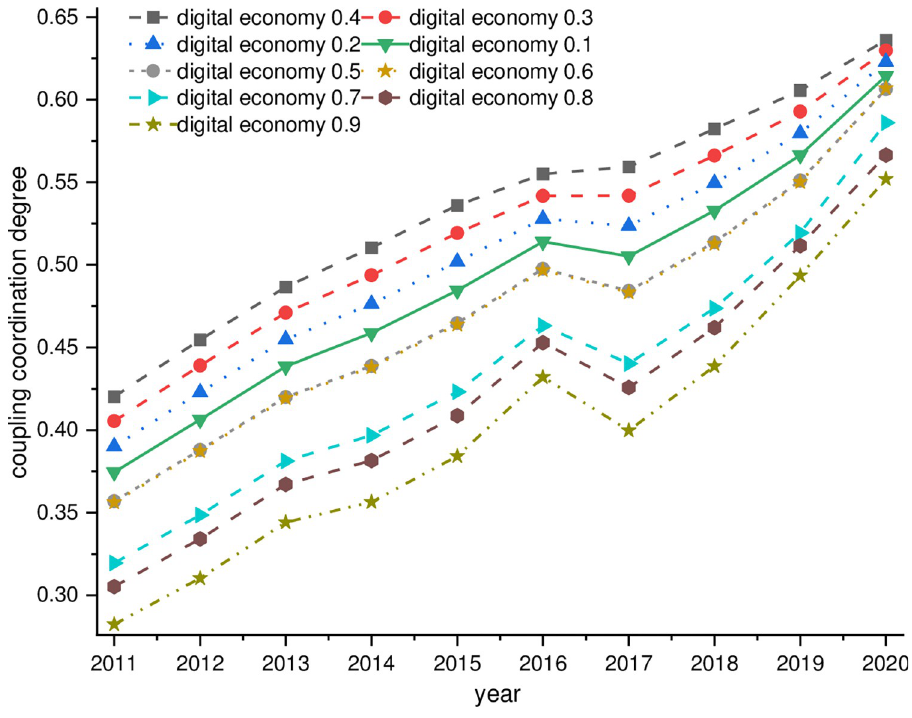
Fig 10. Effect of various weight